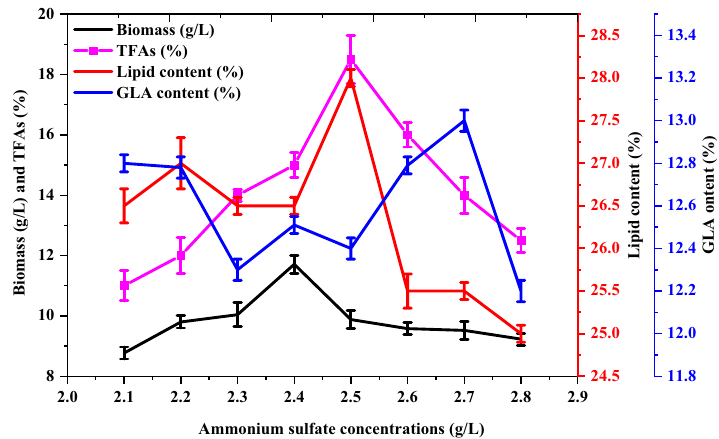
Figure 5. Effect of different ammonium sulfate concentrations as the nitrogen source on biomass (g/L), lipid (%), TFA and GLA (%) yields from M. plumbeus and B. subtilis cocultures